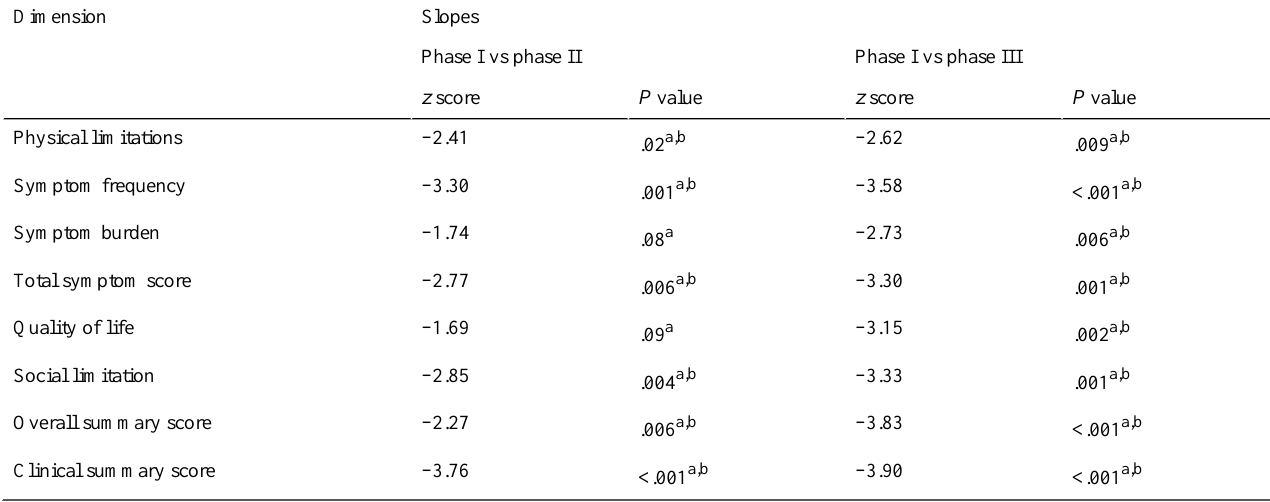
Table 4. z scores and significance levels from the Wilcoxon signed-rank post hoc tests when testing for differences in trends on the Kansas City Cardiomyopathy Questionnaire in terms of slopes between the